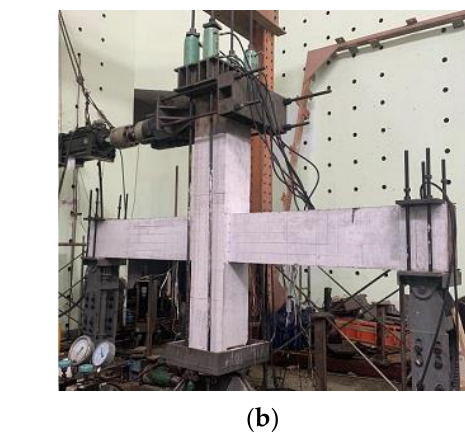
Figure 4. Test setup. ( a ) Schematic, ( b ) pictures.